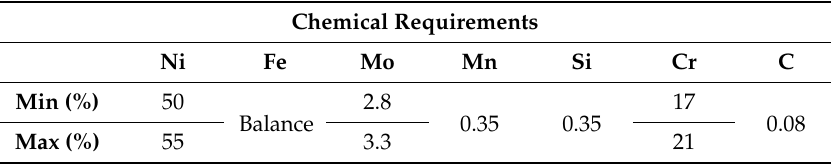
Table 2. Chemical composition of Inconel 718 (UNS N07718).